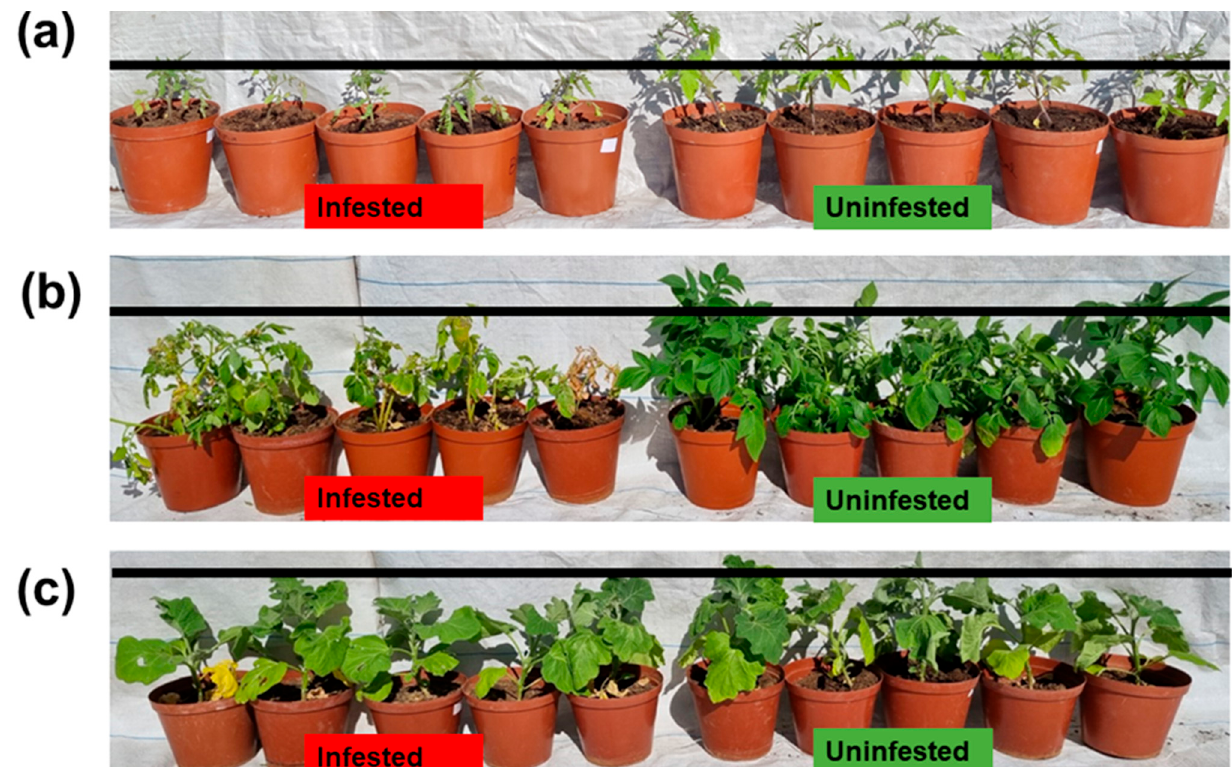
Figure 4. Comparisons of plant height, leaf color, and number of leaves between the uninfested and Tuta absoluta -infested tomato ( a ), potato ( b ), and eggplant ( c ) .